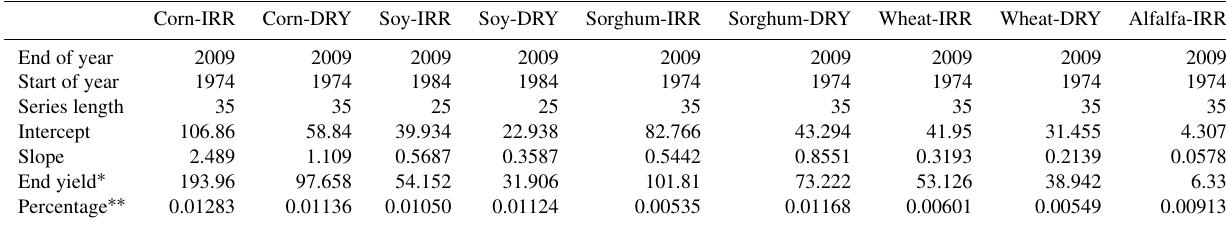
Table A2. Historic yields in crop varieties (irrigated and